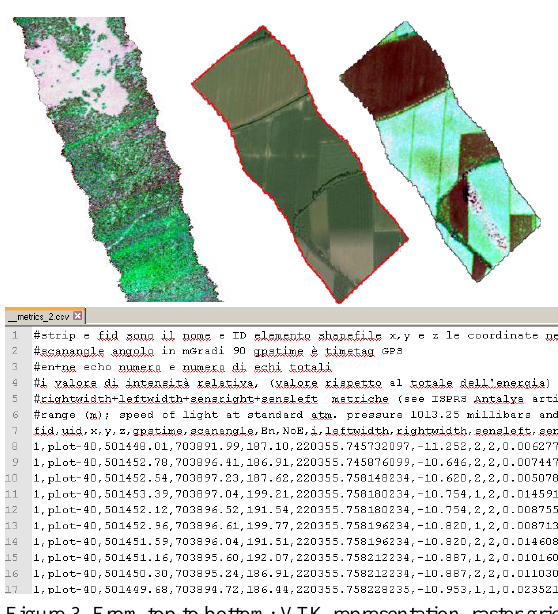
Figure 3. From top to bottom: VTK representation, raster grid representation and CSV representation of metrics extracted from the